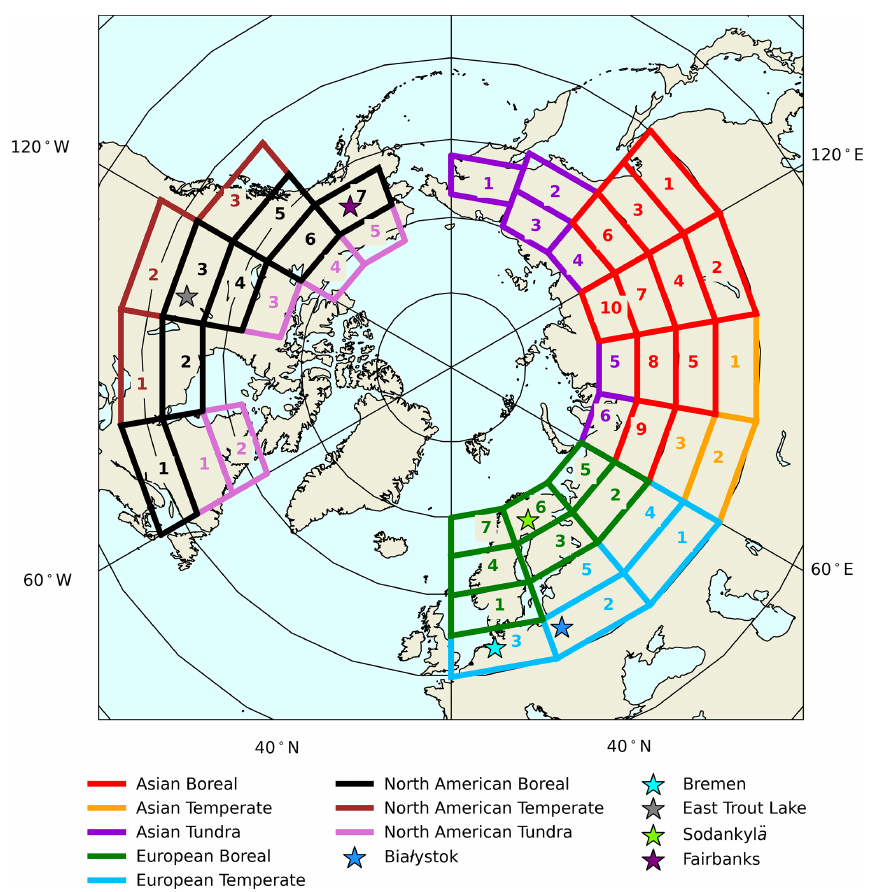
Figure 1. Map for of regions, zones, and locations of ground-based X CO